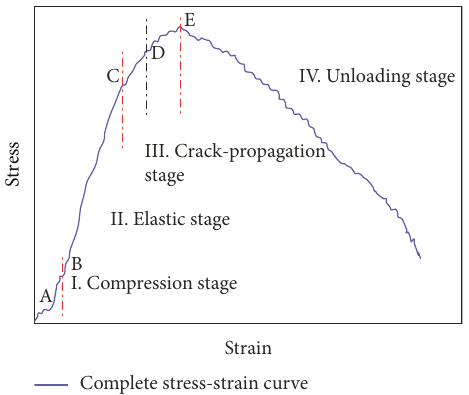
Figure 6: The typical complete stress – strain curve under impact